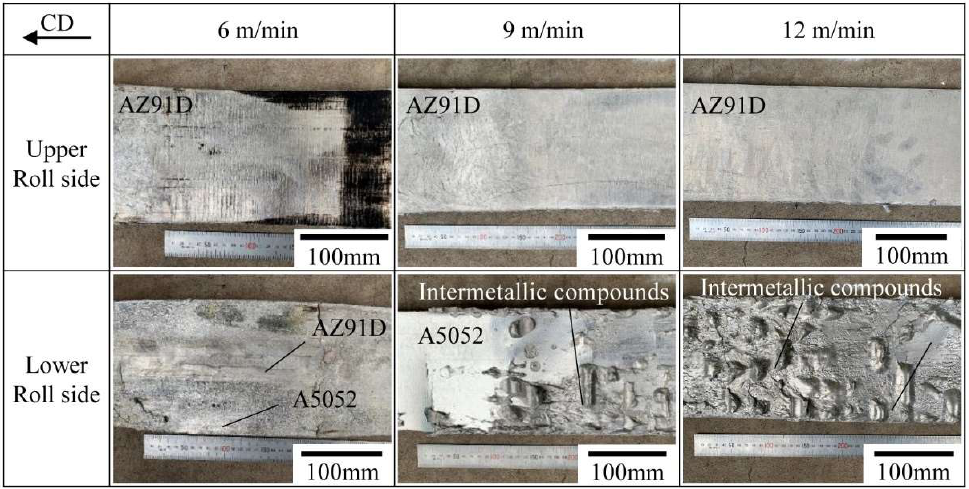
Figure 5. Surface of the AZ91D/A5052 strips cast using the second pouring sequence with different roll speeds.